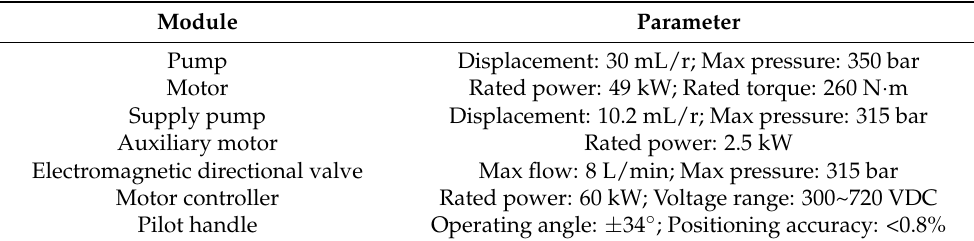
Table 1. Key parameters of experimental platform.